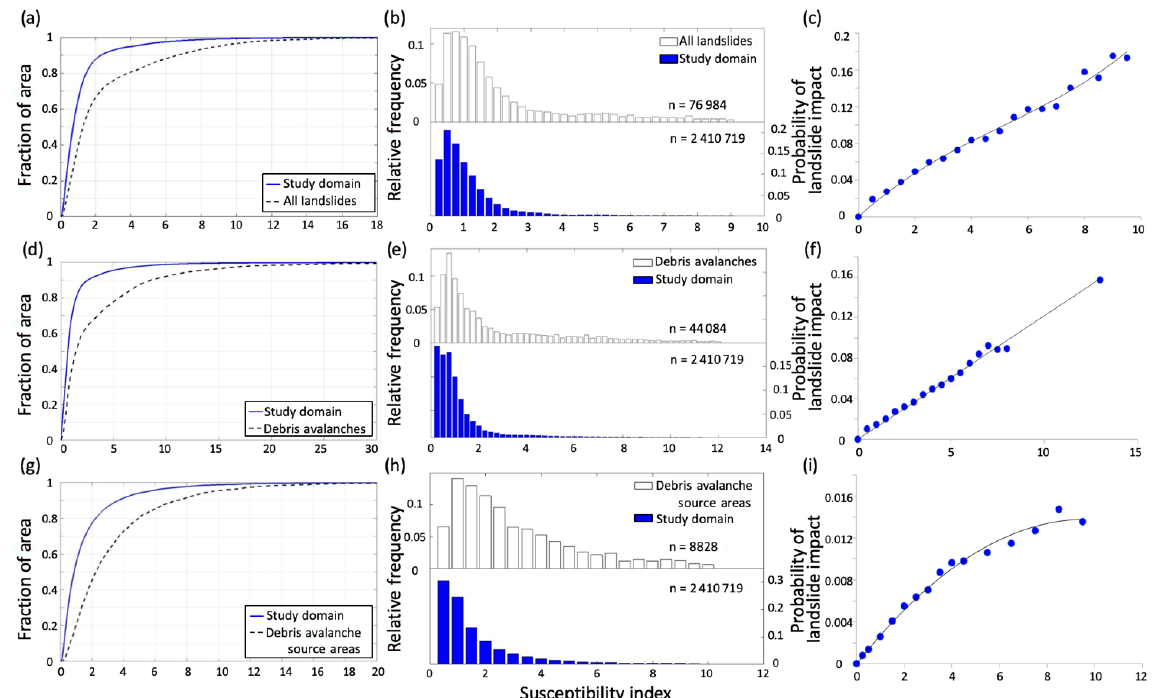
Figure 6. Cumulative distributions (a, d, g) and relative frequency plots (b, e, h) of the susceptibility index (SI) for all grid cells included in the analysis and the grid cells contained within mapped landslides. The probability of a landslide impact, P (LS r | SI r ), calculated from the ratio of the number of landslide cells to the number of all cells within each SI bin, with fitted curves (c, f, i) . Rows represent analysis domains: all landslide types (a–c) ; debris avalanches (d–f) ; and debris avalanche source areas (g–i)